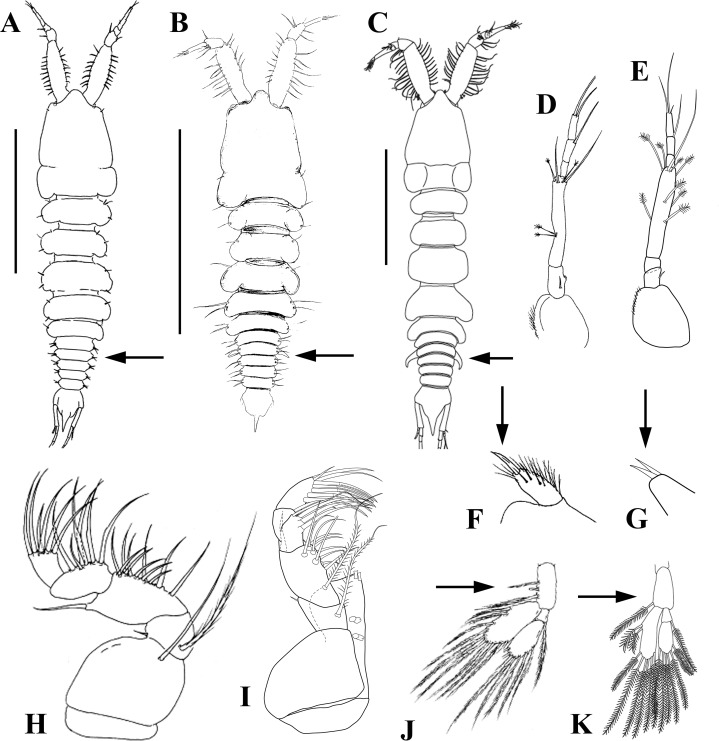
Female dorsal view.(A) Sphyrapus meknes; (B) Sphyrapus malleolus; (C) Sphyrapus caribensis sp. nov. Antenna; (D) Sphyrapus meknes; (E) Sphyrapus caribensis sp. nov. Labium; (F) Sphyrapus malleolus; (G) Sphyrapus caribensis sp. nov. Maxilliped; (H) Sphyrapus malleolus; (I) Sphyrapus caribensis sp. nov. Pleopod; (J) Sphyrapus malleolus; (K) Sphyrapus caribensis sp. nov. [Figures modified from: A, B, D, F, and H, Błażewicz-Paszkowycz, Bamber & Cunha (2011); C, E, G, and I, Morales-Núñez et al. (this study)]. Not to scale.